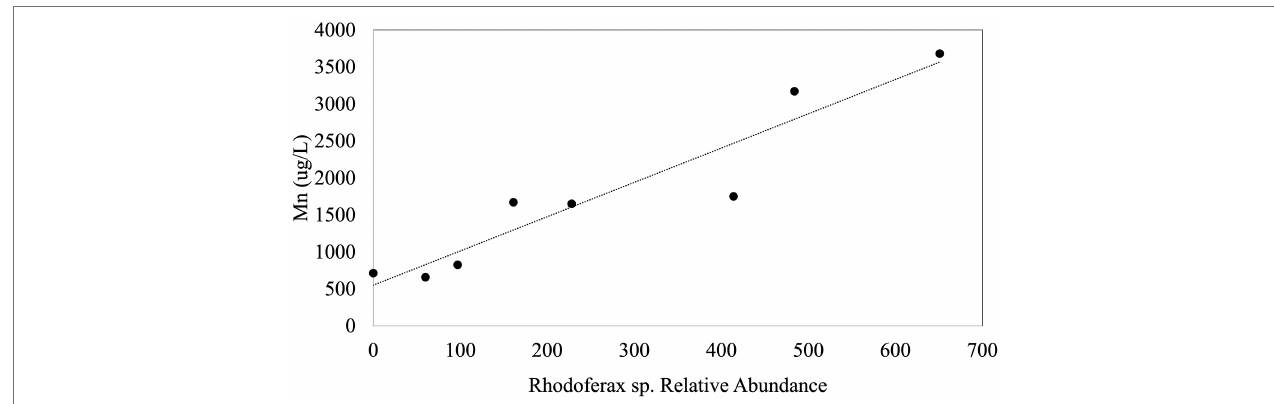
FIGURE 4 | Plot of the linear regression between the relative abundance of the sulfolane degrading species and Mn during week 10 of AS system operation ( p < 0.001; R 2 =